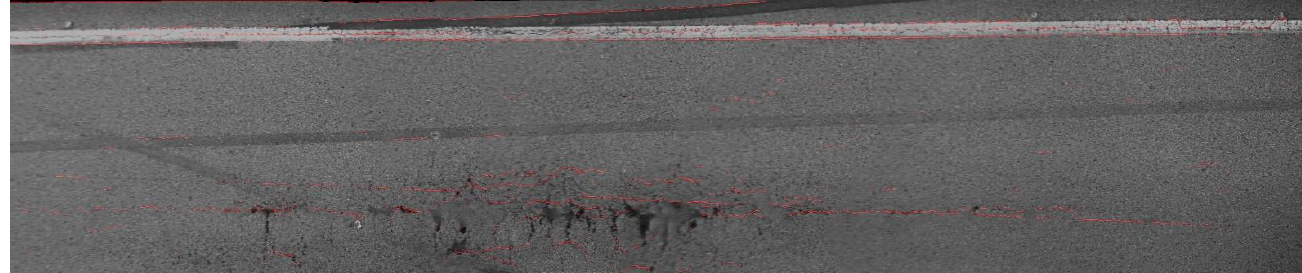
Figure 14. Road lane section segmented by the segmentation neural network.